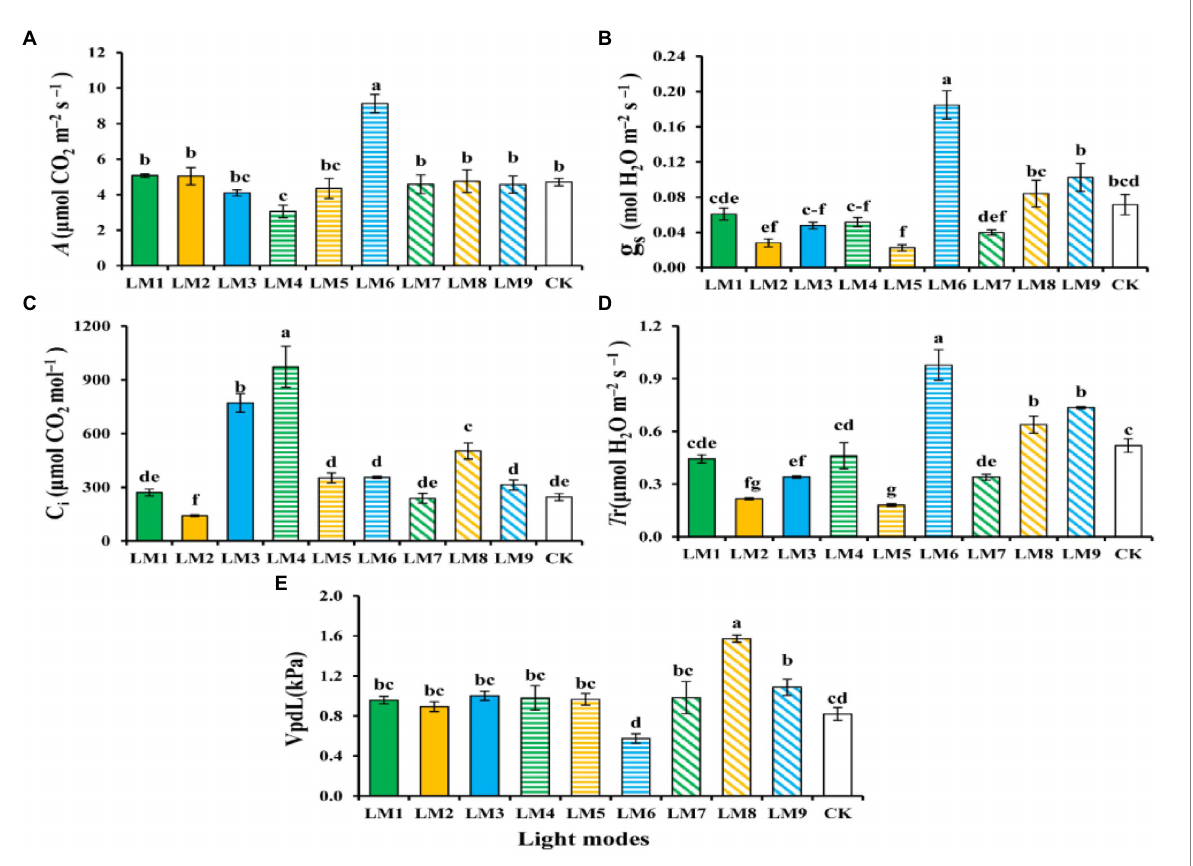
FIGURE 10 The influence of modes of LED light on photosynthetic characteristics [Net photosynthetic rate (A) , Stomatal conductance ( g s ) (B) , Leaf transpiration rate ( T r) (C) , intercellular CO 2 concentration (CI) (D) , and Air vapor pressure (VpLd) (E) ] of strawberry leaves. Each column represents the means of 16 (4 × 4) repeats; the same letter within the same series is not significantly different according to Duncan’s multiple range test ( p ≤